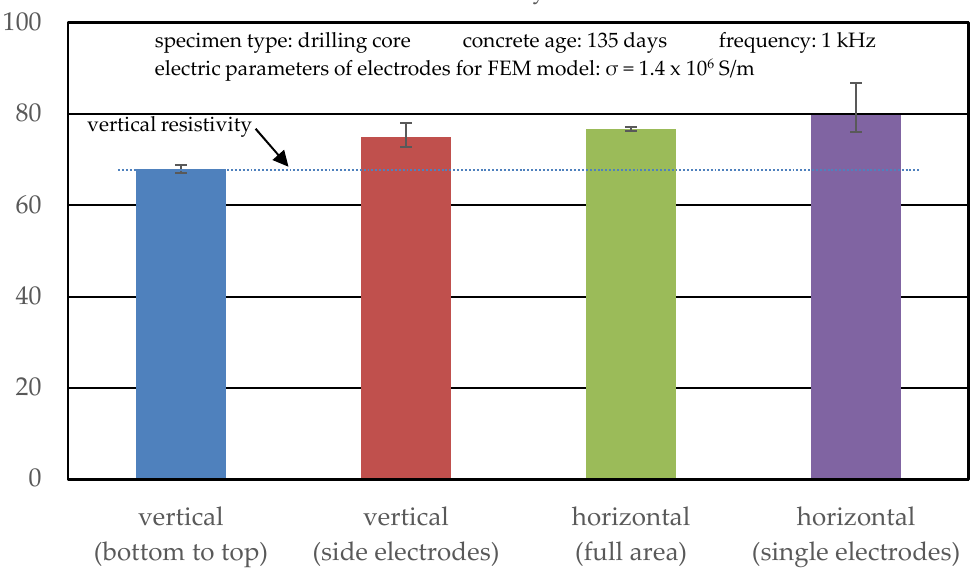
Figure 10. Calculated electrical resistivity of PC drilling cores in different electrode configurations, simulated with the conductivity of steel.